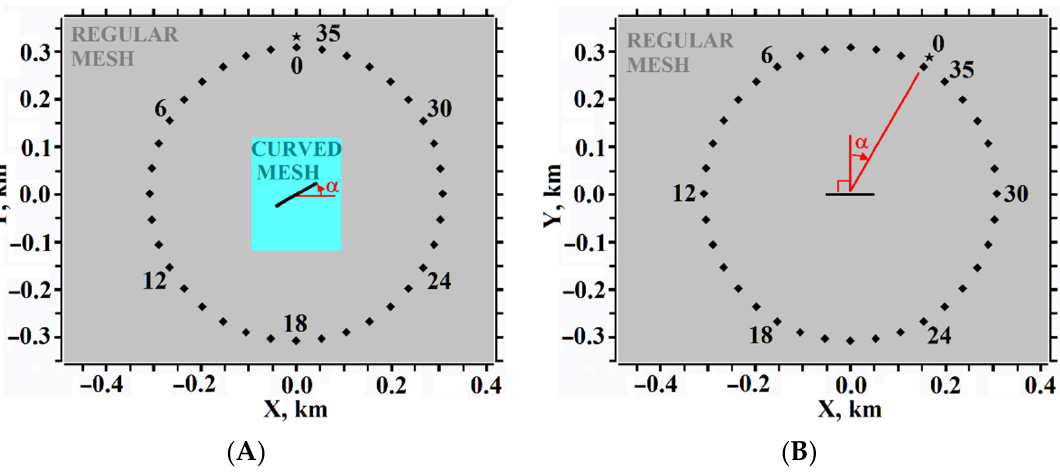
Figure 4. Examples of structured curvilinear meshes around fractures for different fracture inclina- tion angles: ( A ) 30°; ( B ) 45°; ( C ) 75°.